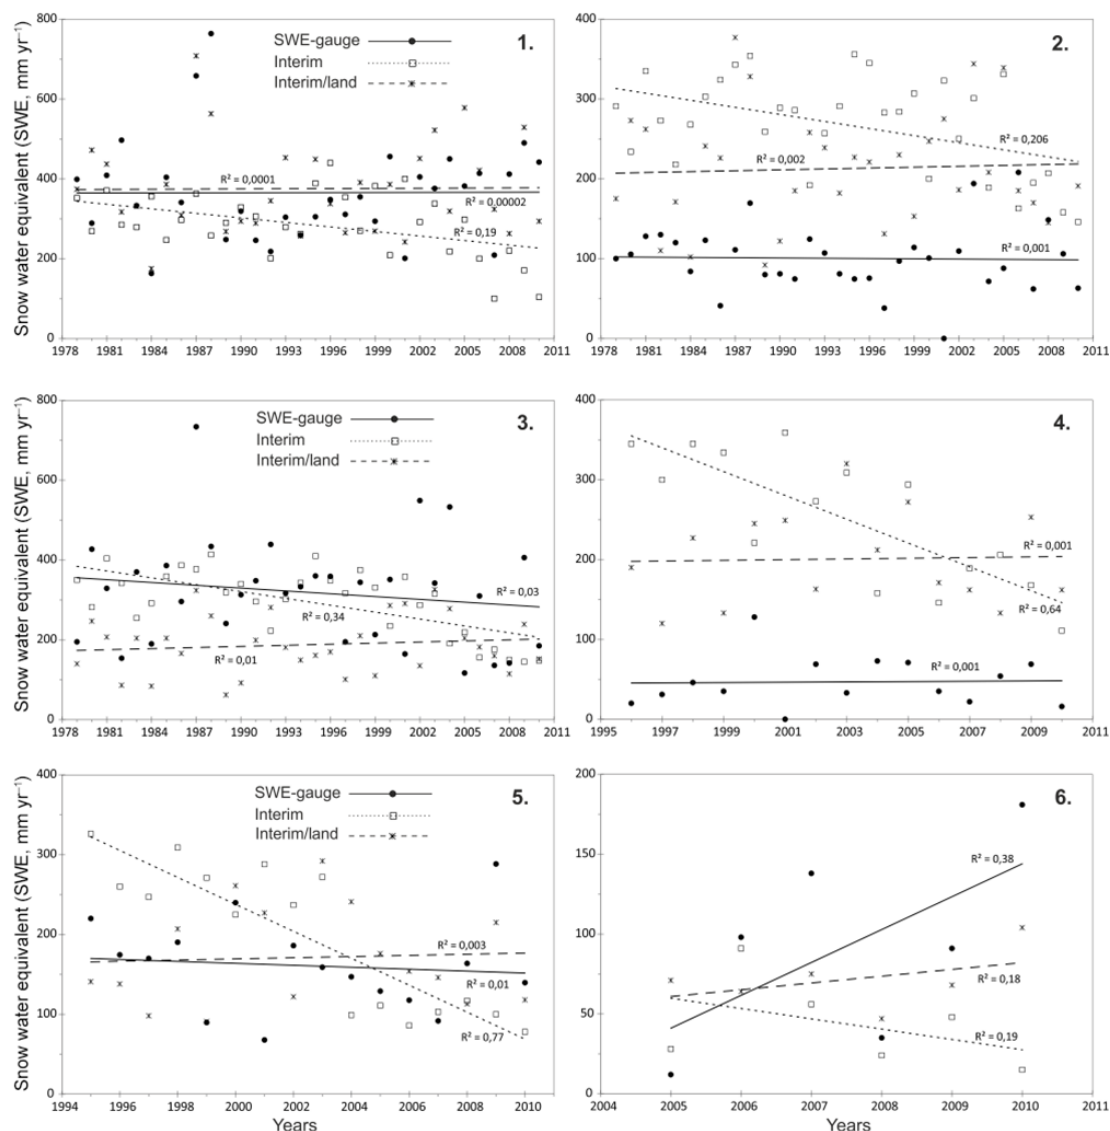
Figure 8. Plots 1–6 indicate the comparison of the yearly SWE from the snow gauges with the corresponding grids from ERA-Interim and Interim/Land. While the time series of SWE covered the whole study period for stations 1–3, the station data were available for a much shorter period for 4–6. The locations of the stations are shown in Fig. 7a,